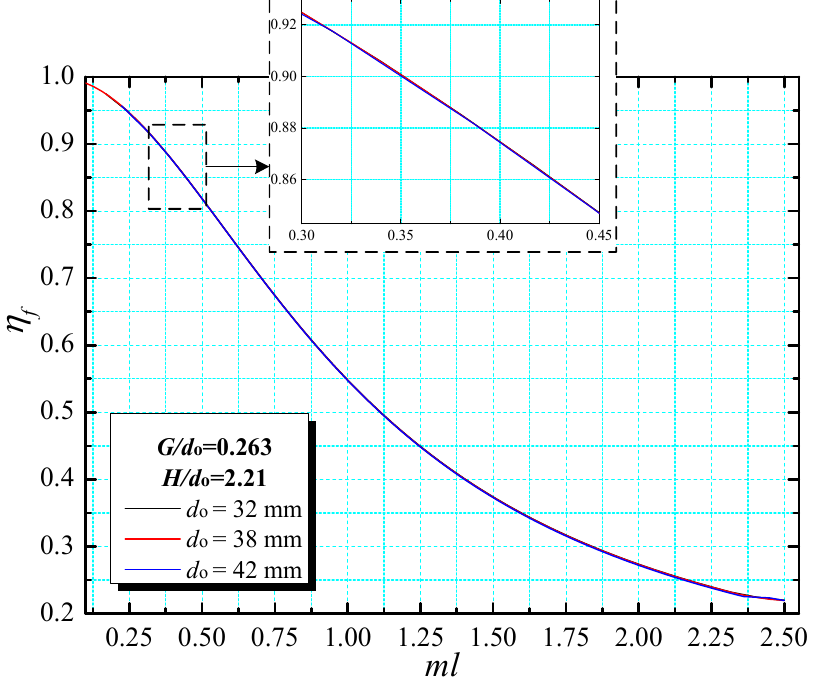
Figure 4. Influence of three diameters d o on the fin efficiency of H-type fins when G / d o = 0.263 and H / d o = 2.21.